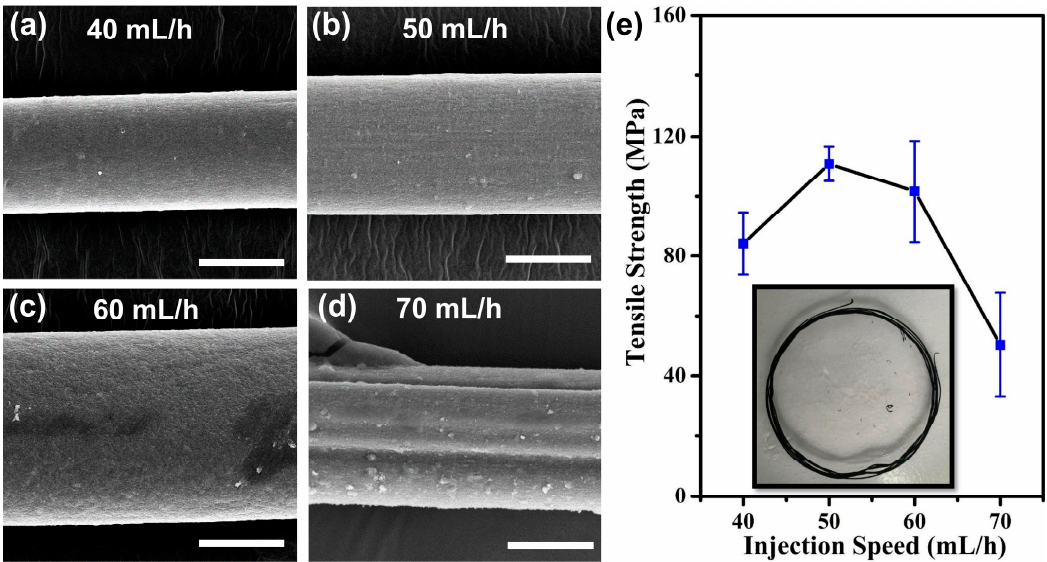
Figure 5. SEM images and tensile strength of the HA/MWCNT hybrid microfibers prepared with different injection speeds (scale bars: 40 μ m). ( a ) Injection speed is 40 mL/h; ( b ) Injection speed is 50 mL/h; ( c ) Injection speed is 60 mL/h; ( d ) Injection speed is 70 mL/h; ( e ) Tensile strength results.